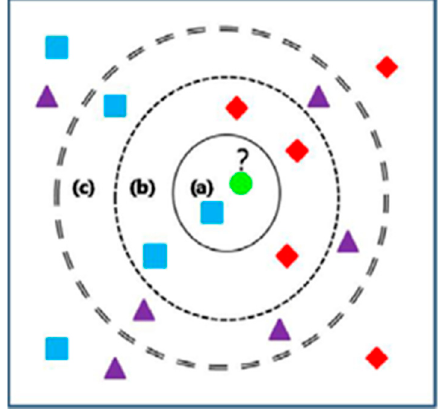
Figure 9. KNN classification. (a), (b) and (c) means that the classification results of KNN are differ- ent under different K values under different K